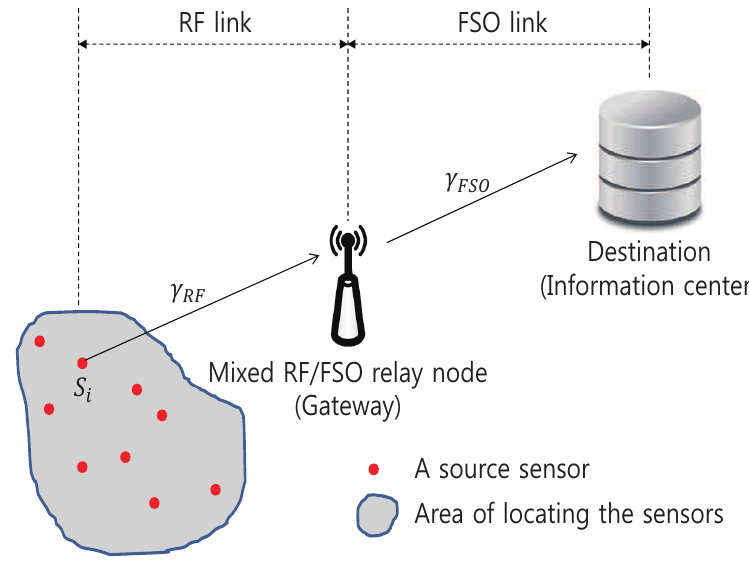
Figure 1. The system